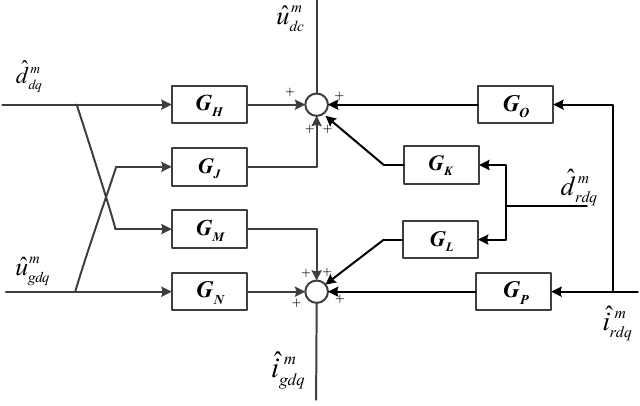
Figure 10. The small-signal transfer diagram of the GSC circuit.